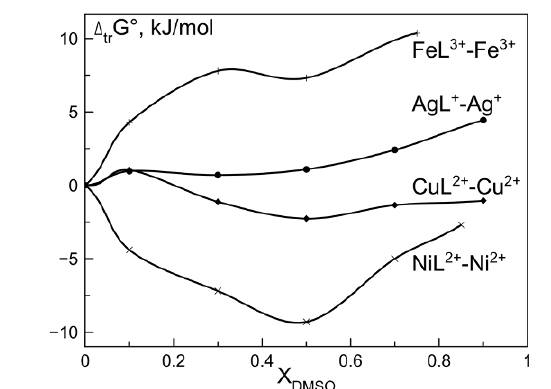
Figure 3. The differences between solvation contributions of AgL + and Ag + , CuL 2+ and Cu 2+ , NiL 2+ and Ni 2+ , FeL 3+ and Fe 3+ ions at their transfer from water to aqueous dimethyl sulfoxide